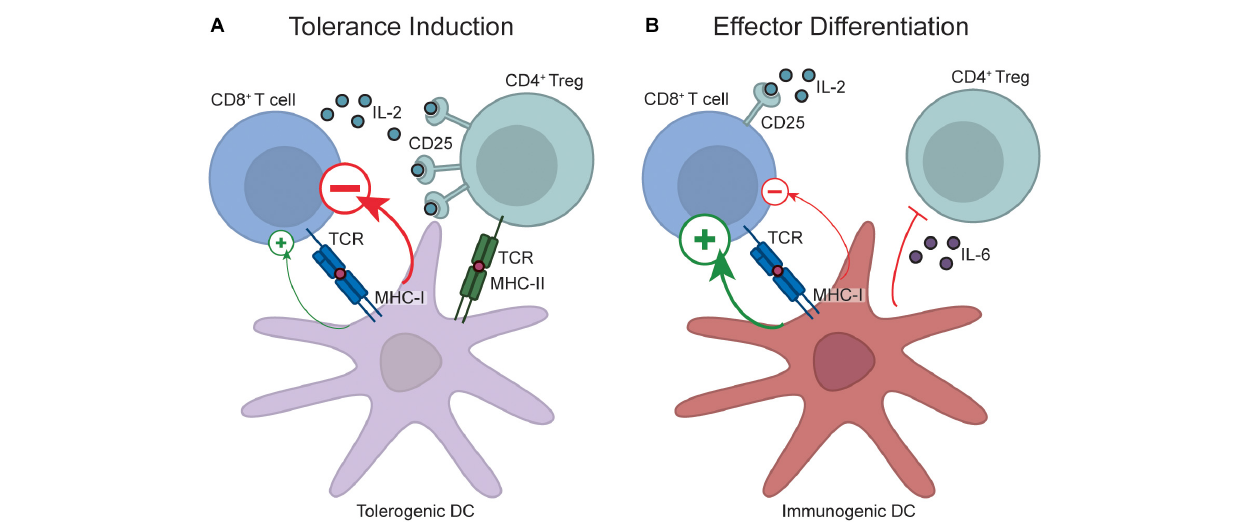
FIGURE 1 | Regulation of CD8 + T cell peripheral tolerance by DCs and Tregs. During tolerance induction (A) , naïve CD8 + T cells encounter antigen on resting, “tolerogenic” DCs. These DCs transmit a net negative signal to responding T cells, which prevents effector differentiation and diverts T cells down a fate of tolerance. Tolerance induction also requires Treg engagement with the DC, and Treg-DC interactions enable proximity-based IL-2 quenching via CD25, and also potentially enforce tolerance by Treg-mediated DC conditioning. In contrast, during effector differentiation (B) , DCs transition into an immunogenic state upon recognition of pathogen-derived products and pathological tissue damage. Antigen recognition on immunogenic DCs programs acquisition of an effector fate due to delivery of a net positive signal. Additionally, inflammatory cytokines produced by immunogenic DCs, such as IL-6, may inhibit Treg-mediated immunosuppression by rendering CD8 + T cells resistant to Treg suppression, while production of other inflammatory cytokines during infection or sterile inflammation, such as IL-12, may also act directly on CD8 + T cells to promote effector differentiation. Note that despite the role of factors like PD-L1 in tolerance induction, it is not possible to distinguish immunogenic from tolerogenic DCs by the expression of any single marker, and instead the overall balance of positive and negative signals likely dictates outcome.